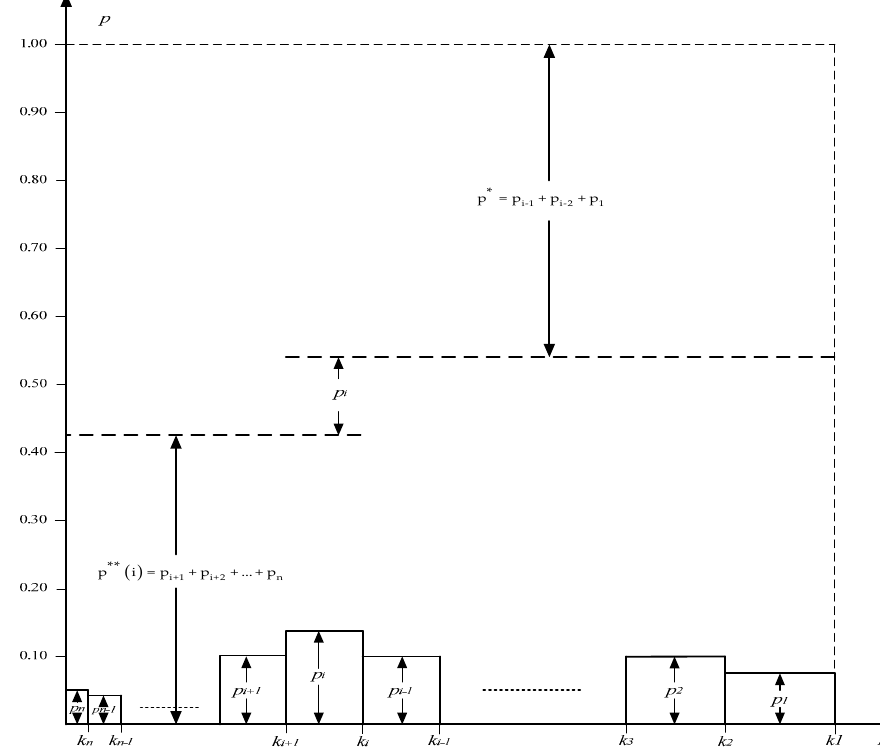
Figure 2. Graphical representation of good and bad news probabilities for prospect A = ( k 1 , p 1 , . . . , k n , p n ) with k 1 > k 2 > . . . > k n .